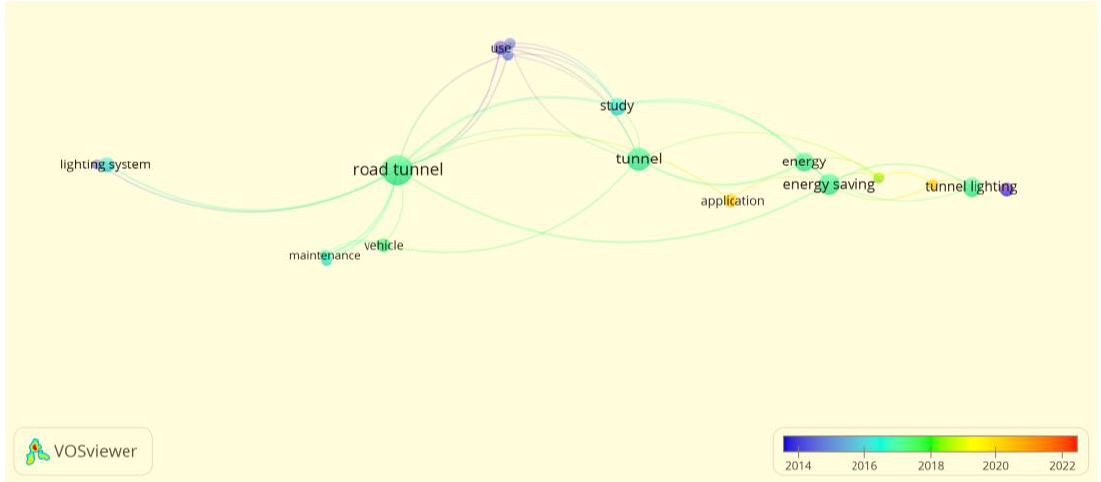
Figure 3. Mapping of most relevant terms.